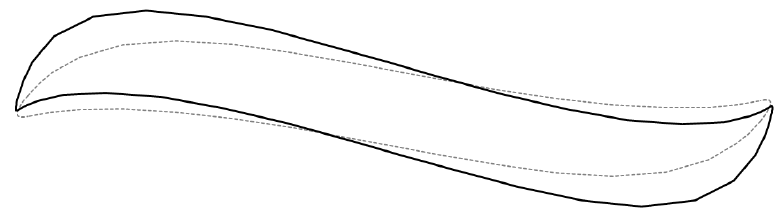
Figure 29. Final blade design compared to the old optimum (dashed).